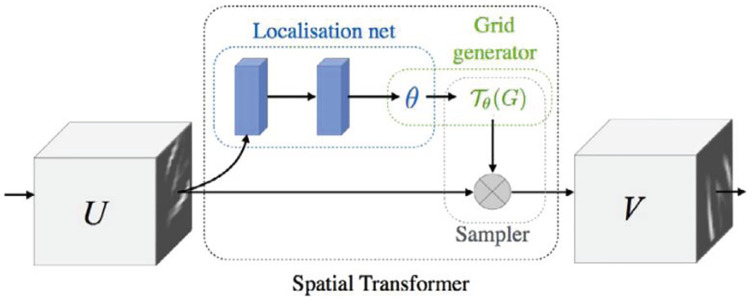
The components of spatial transformer network [27].